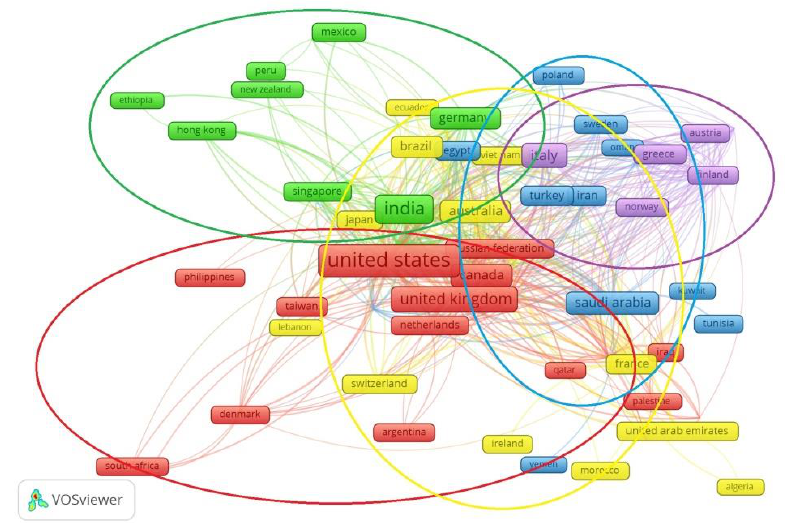
Figure 2. Co-authorship of scientists in scientific articles indexed by the Scopus scientometric database. Source: developed by the authors, using Vosviewer.